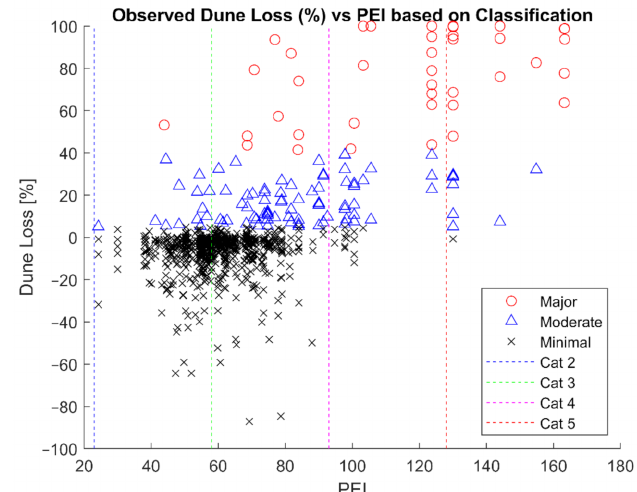
Figure 5. Observed dune loss percentage as a function of storm intensity (PEI) alone; each data point represents observations from a single profile. X-axis is storm intensity (PEI). Storm categories are denoted by colored vertical dashed lines. The Y-axis is dune loss percentage. Red circles indicate Major loss (>40%), blue circles indicate Moderate (>5% but <40%). Negative dune loss indicates accretion.